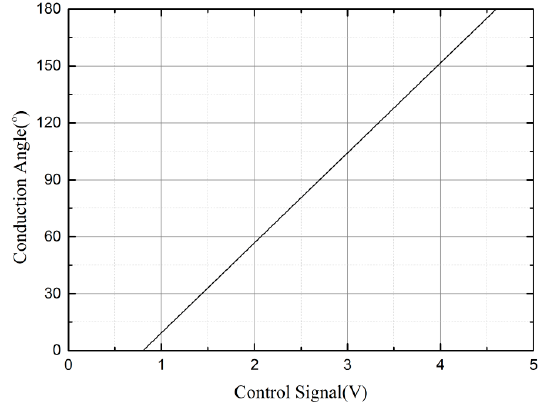
Figure 7. The control diagram of the MT2DC.